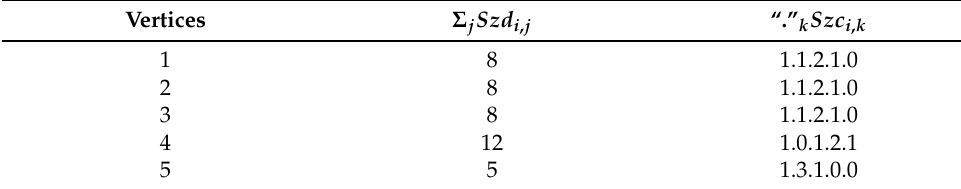
Table 9. Two orders for the same partition of Figure 1 vertices. Vertices Σ j Szd i , j